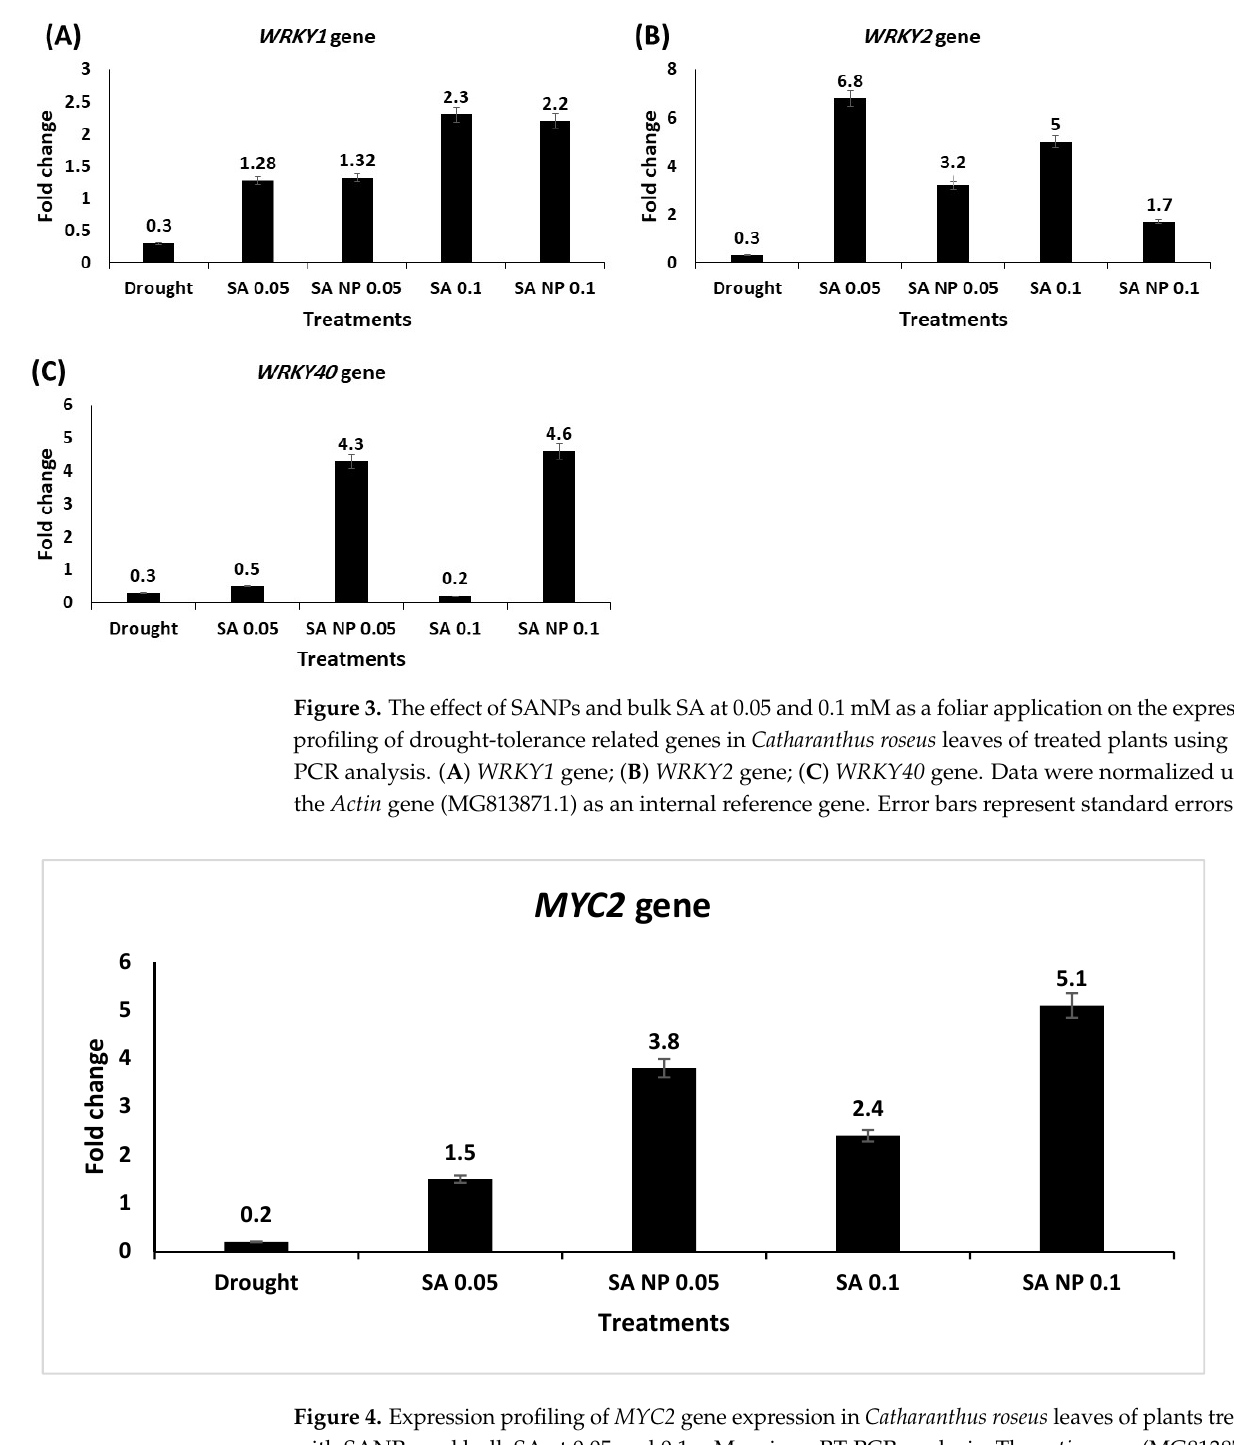
was used as an internal reference gene for data normalization. Error bars represent standard errors.